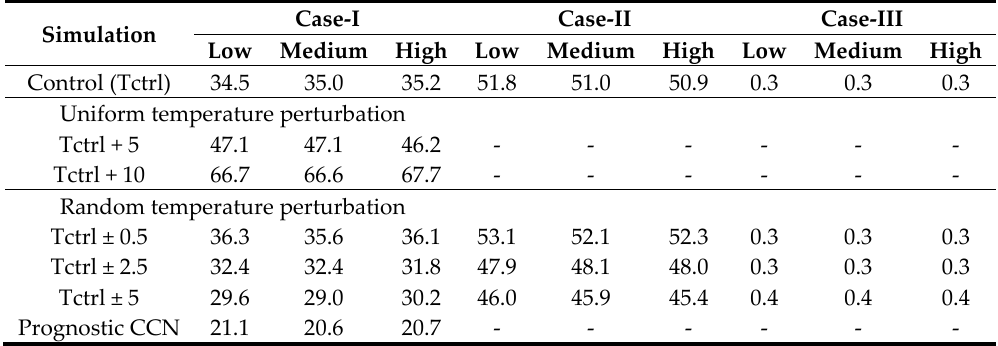
Table 3. Inter-comparison of accumulated rainfall (mm). Dashes indicate no simulations were performed for the